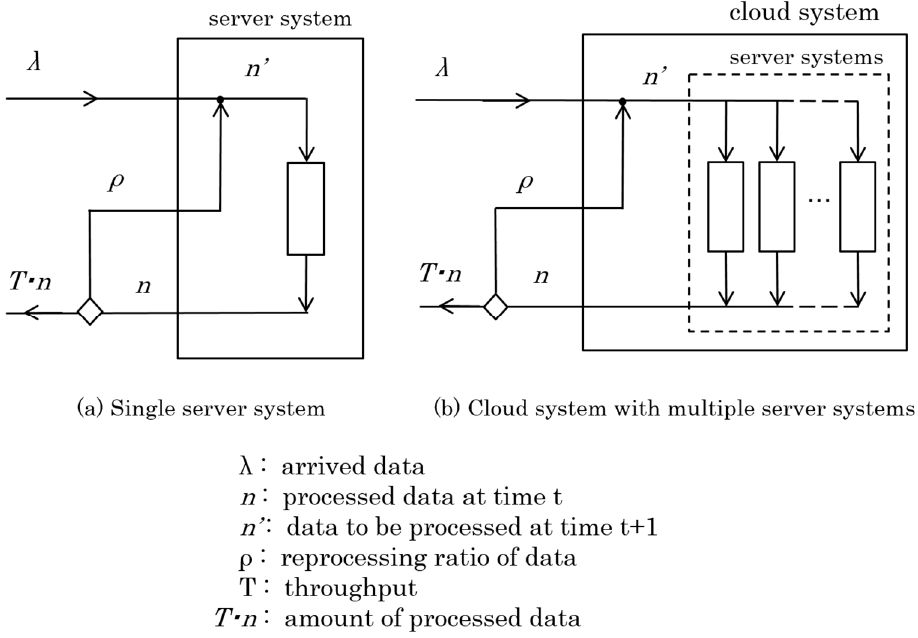
Figure 4. System model in the internet environment.